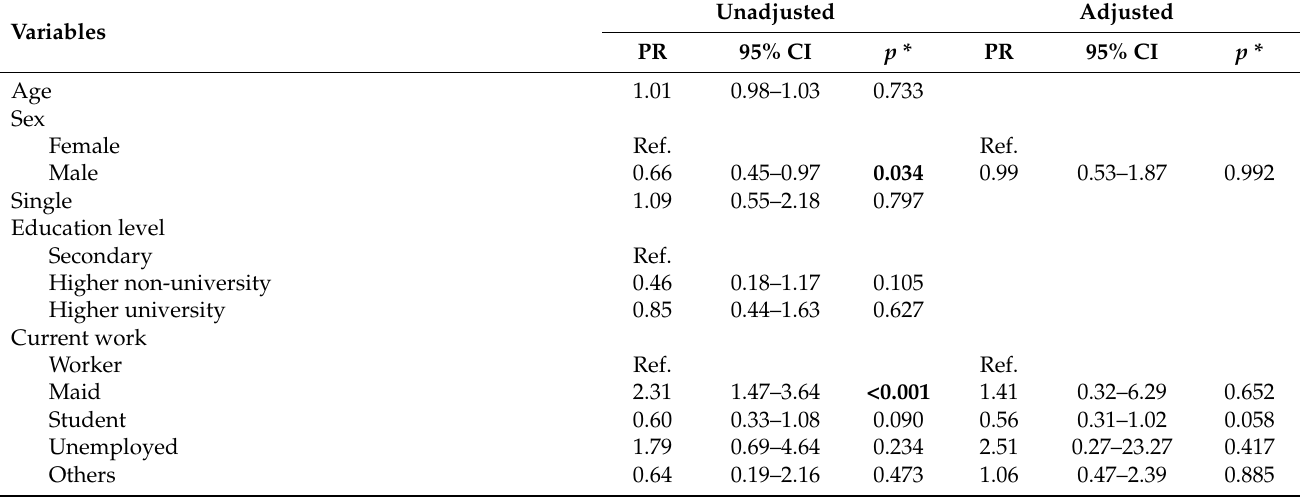
Table 3. Factors independently associated with